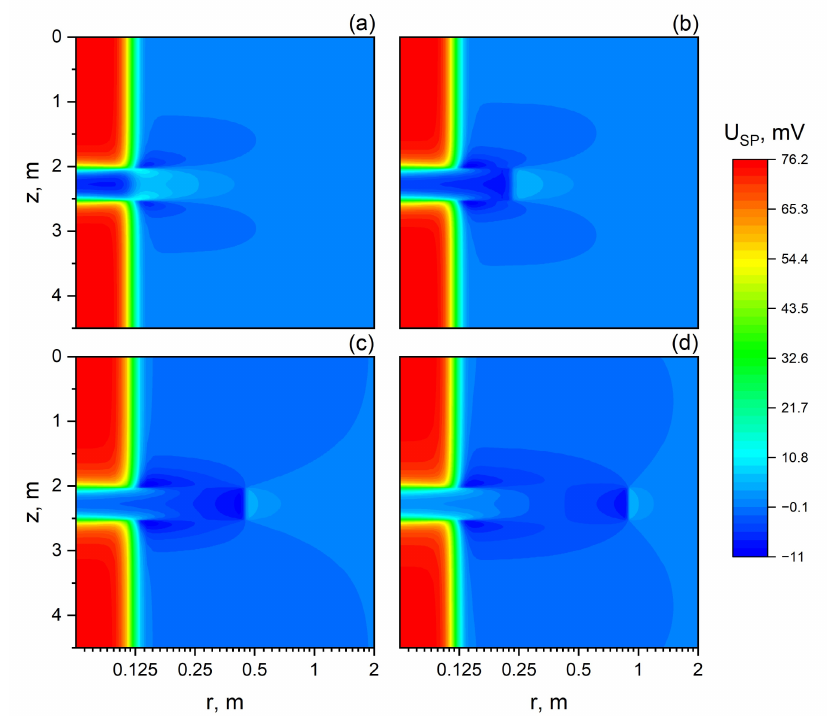
Figure 9. Distribution of SP in the studied area for different radii of the mud filtrate invasion zone in the permeable sandstone bed of 0.5 m thickness. Radius of invasion zone: 0.108 m ( a ); 0.216 m ( b ); 0.432 m ( c ) and 0.864 m ( d